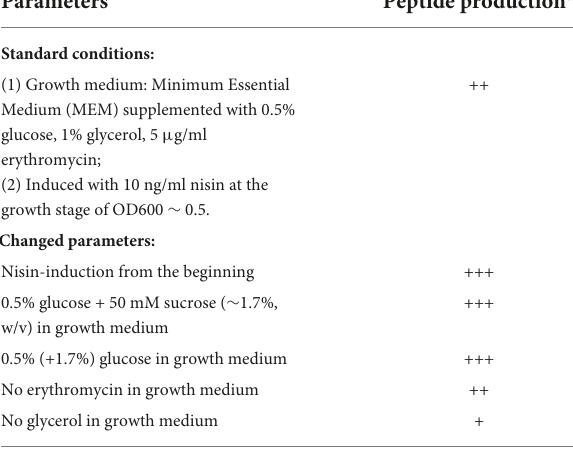
TABLE 2 The influence of various conditions on peptide production of circularin A with the constructed stain (pTLR4-CirABCDE). Parameters Peptide production